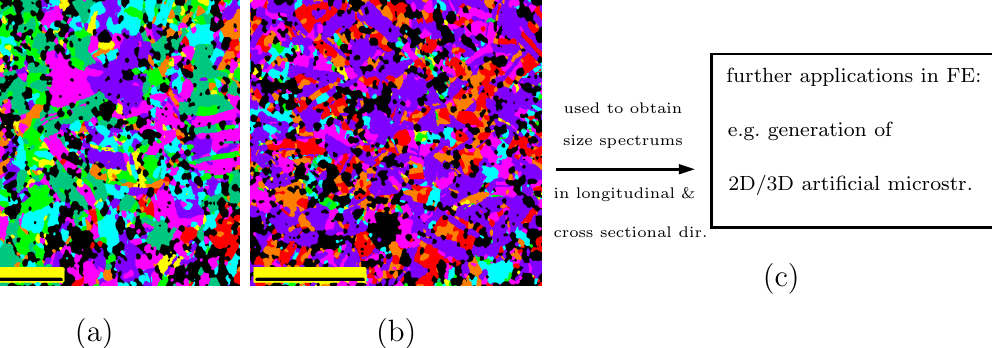
Fig. 11: (a) Segmented image for Fig. 2 (a); (b) segmented image for Fig. 2 (b); (c) an example Figure 11. ( a ) Segmented image for Figure 2a; ( b ) segmented image from Figure 2b; ( c ) an for further applications of ML results in FE simulations. (dir.: direction, microstr.: microstructure)